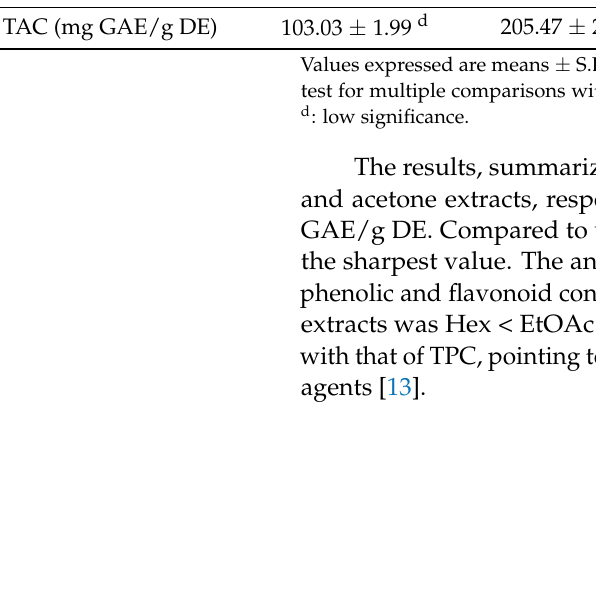
Table 4. Total antioxidant activity of Erodium arborescens aerial part extracts and of vitamin C. Extract Hex EtOAc Acetone MeOH Vit C TAC (mg GAE/g